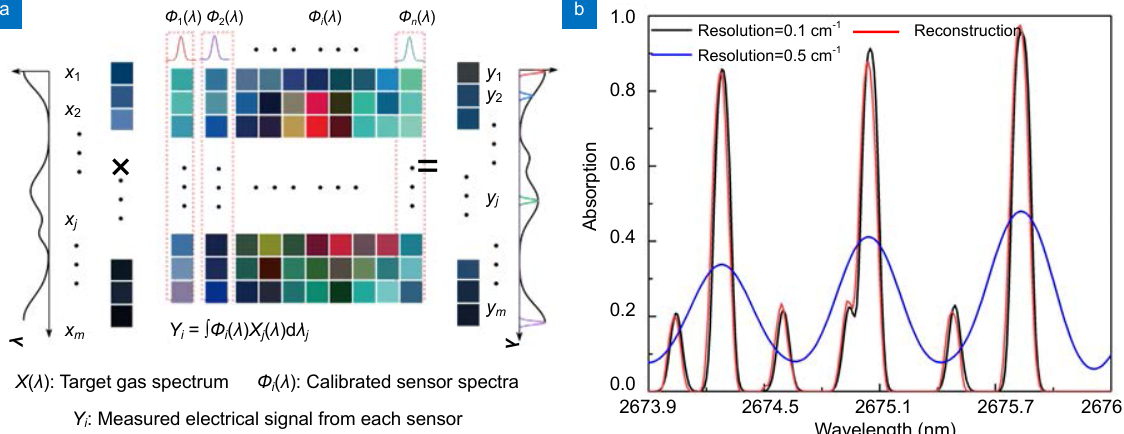
Fig. 6 | Gas molecular fingerprint spectrum reconstruction with the monolithically integrated plasmonic gas sensor array Φ ( λ ). ( a ) Schematic of the reconstruction process for an unknown input signal X ( λ ), where the photoelectric signal Y of each sensor is recorded. ( b ) The recovered spectrum (red line) and the reference spectra by simulation based on HITRAN database (black and blue